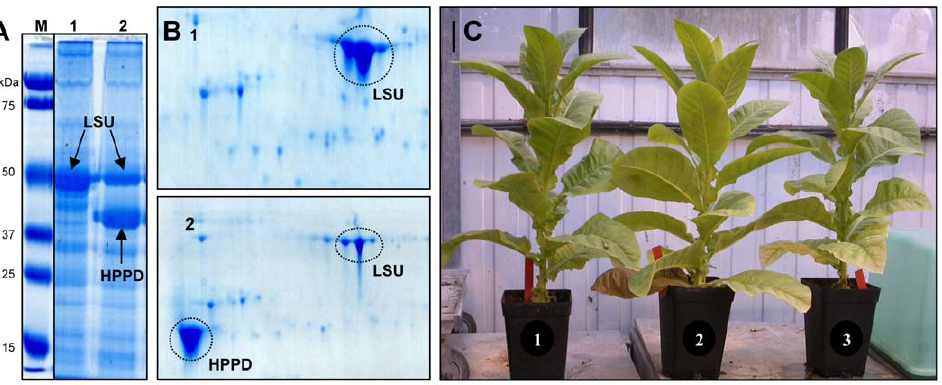
Figure 1. Recombinant HPPD protein accumulation and phenotype of transplastomic tobaccos. (A) Coomassie stained SDS-PAGE and (B) 2D gels of separated protein extracts from leaves of wild type plants (Lane 1 in panel A , Gel 1 in panel B ) and transplastomic tobacco plants accumulating the Pseudomonas fluorescens p -hydroxyphenyl pyruvate dioxygenase (HPPD) (Lane 2 in panel A , Gel 2 in panel B ). The position of the large subunit of Rubisco (LSU) and of the recombinant HPPD is indicated. Molecular weight markers are shown on the left of panel A (Lane M ) together with their molecular weight in kDa. (C) Mature wild-type ( 2 ) and transplastomic plants accumulating recombinant HPPD protein ( 1 , 3 ) observed 15 weeks after sowing and showing an absence of phenotypic